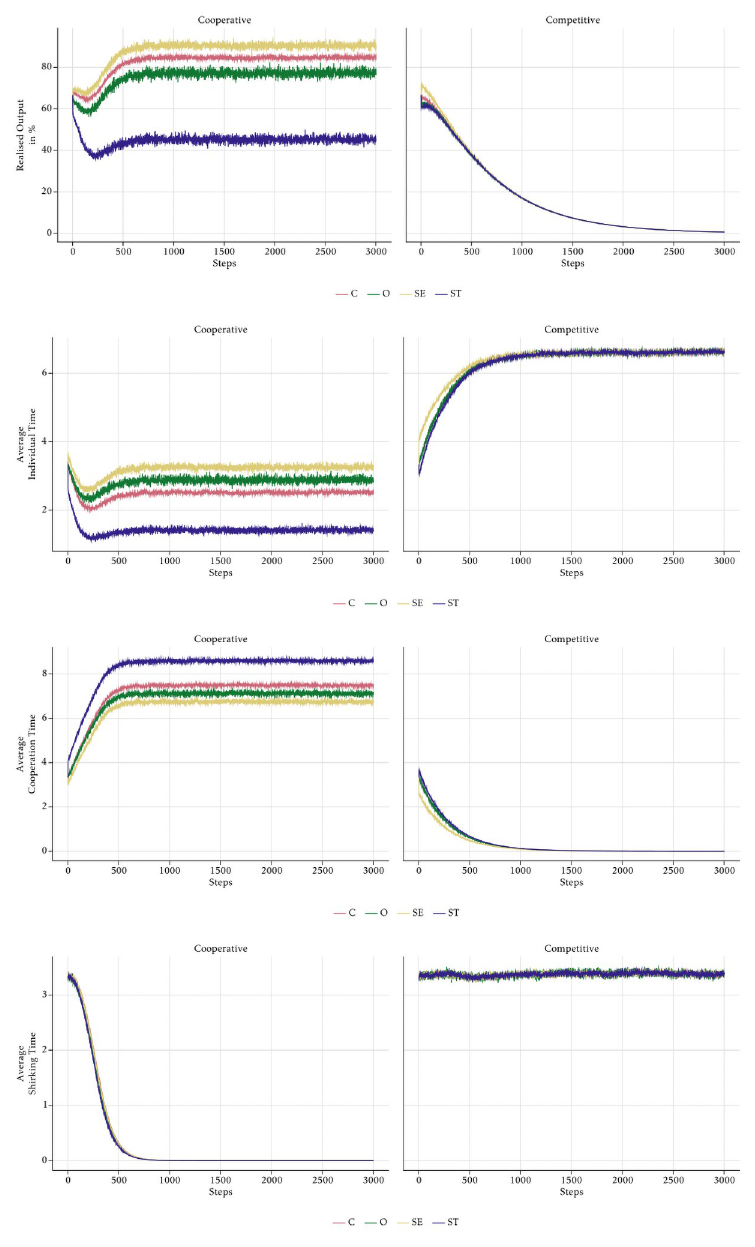
Fig 15. Realised output, average individual, cooperation and shirking time per value-types—No monitoring.